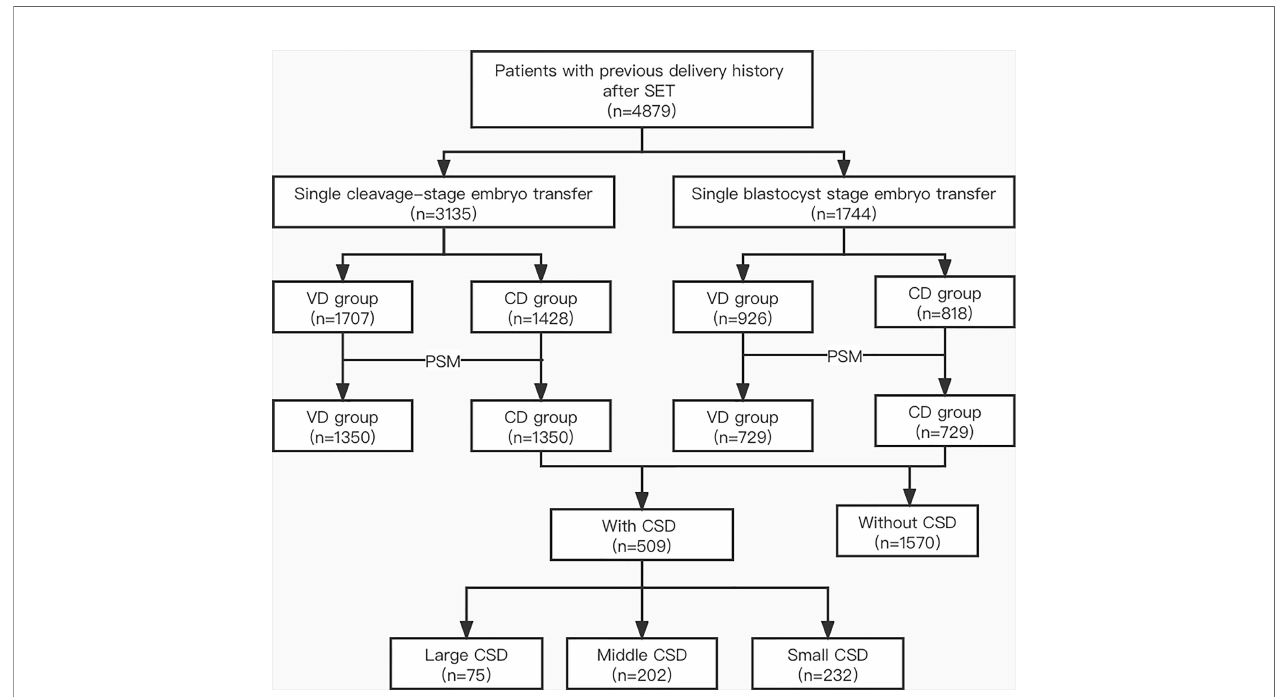
FIGURE 1 | Flow chart of the study. SET, single embryo transfer; VD, vaginal delivery; CD, cesarean delivery; PSM, propensity score matching; CSD, cesarean scar defect.